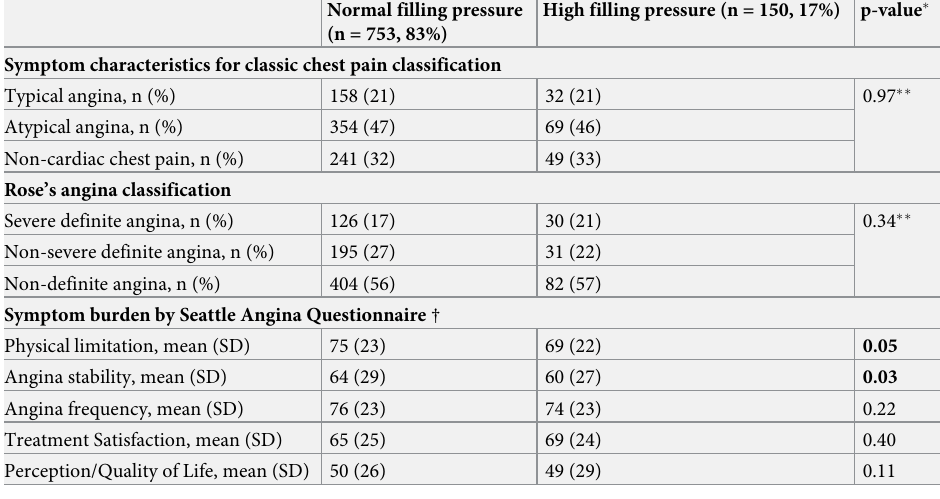
Table 4. Burden of angina symptoms distributed between normal and high filling